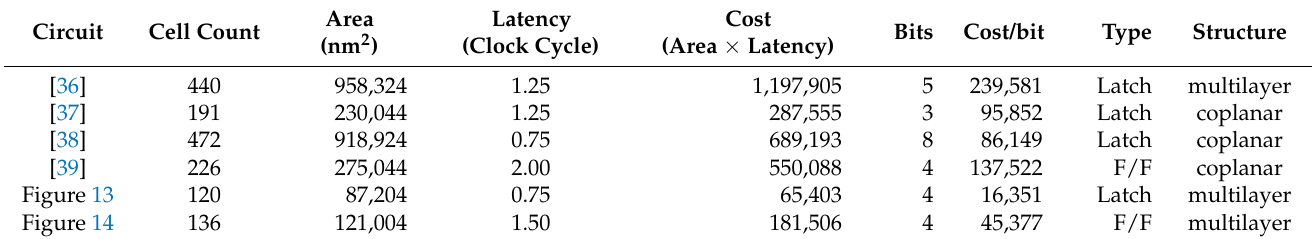
Table 8. Performance comparison of QCA LFSR structure.